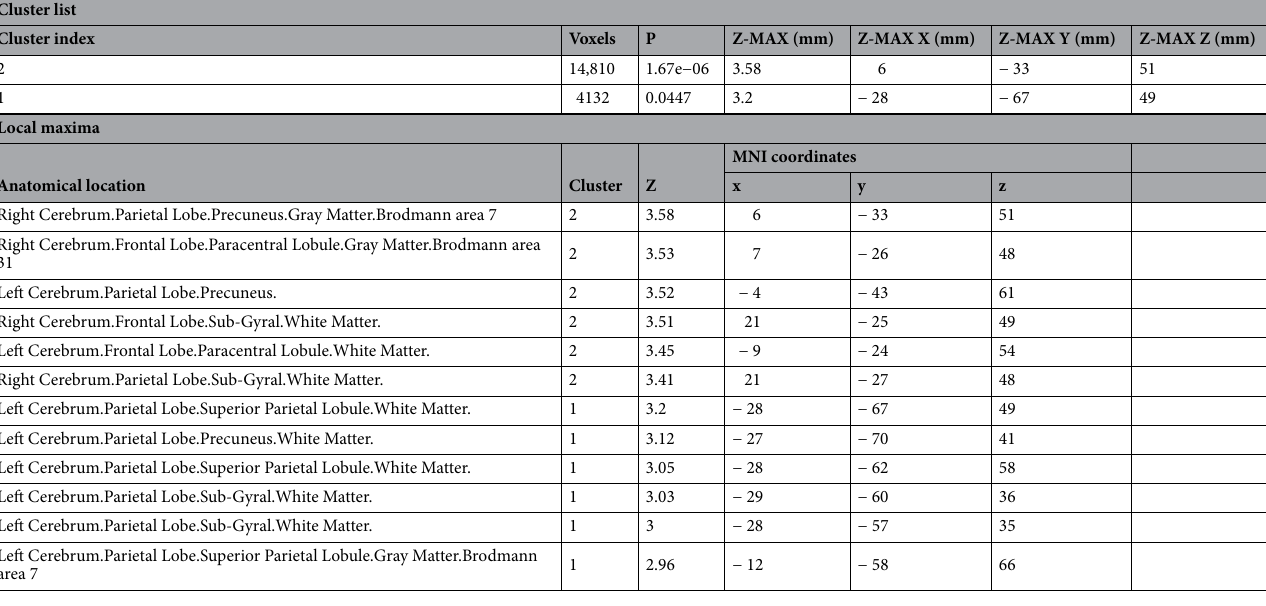
Table 1. Brain areas that showed significant changes in connectivity of the comparison between slope contrast in the real group and slope contrast in the sham group (cluster determined by z > 2.3 and a (corrected) cluster significance threshold of p =